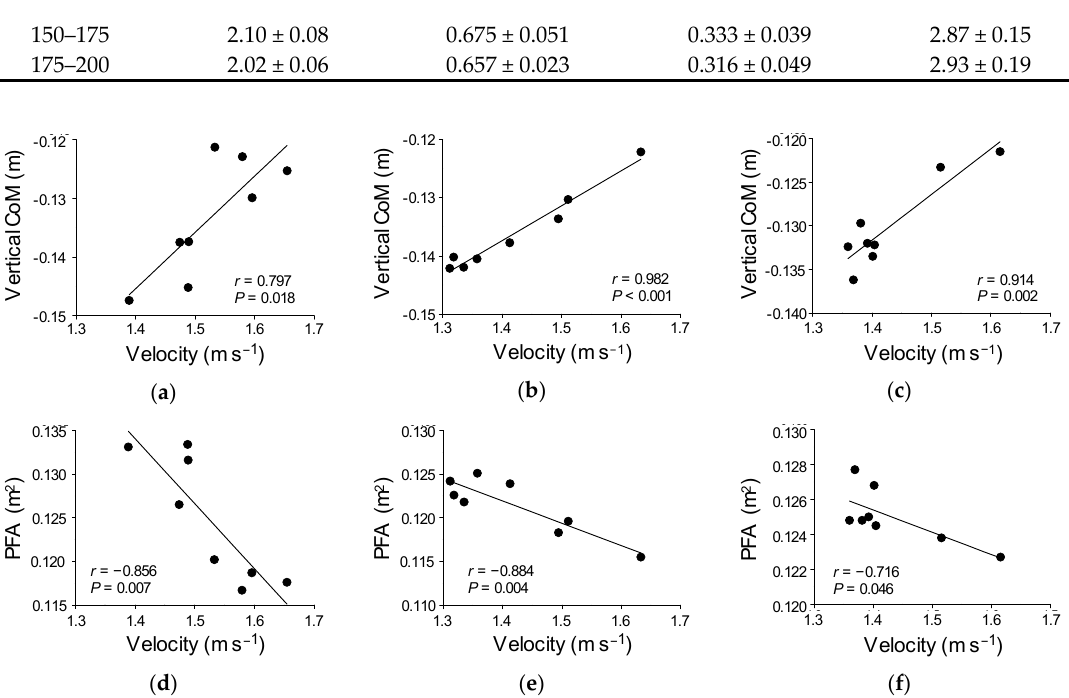
Figure 4. Relationships between swimming velocity and vertical center of mass (CoM) position ( a – c ) and between swimming velocity and projected frontal area (PFA) ( d – f ). ( a , d ) : subject A; ( b , e ) : subject B; ( c , f ) : subject